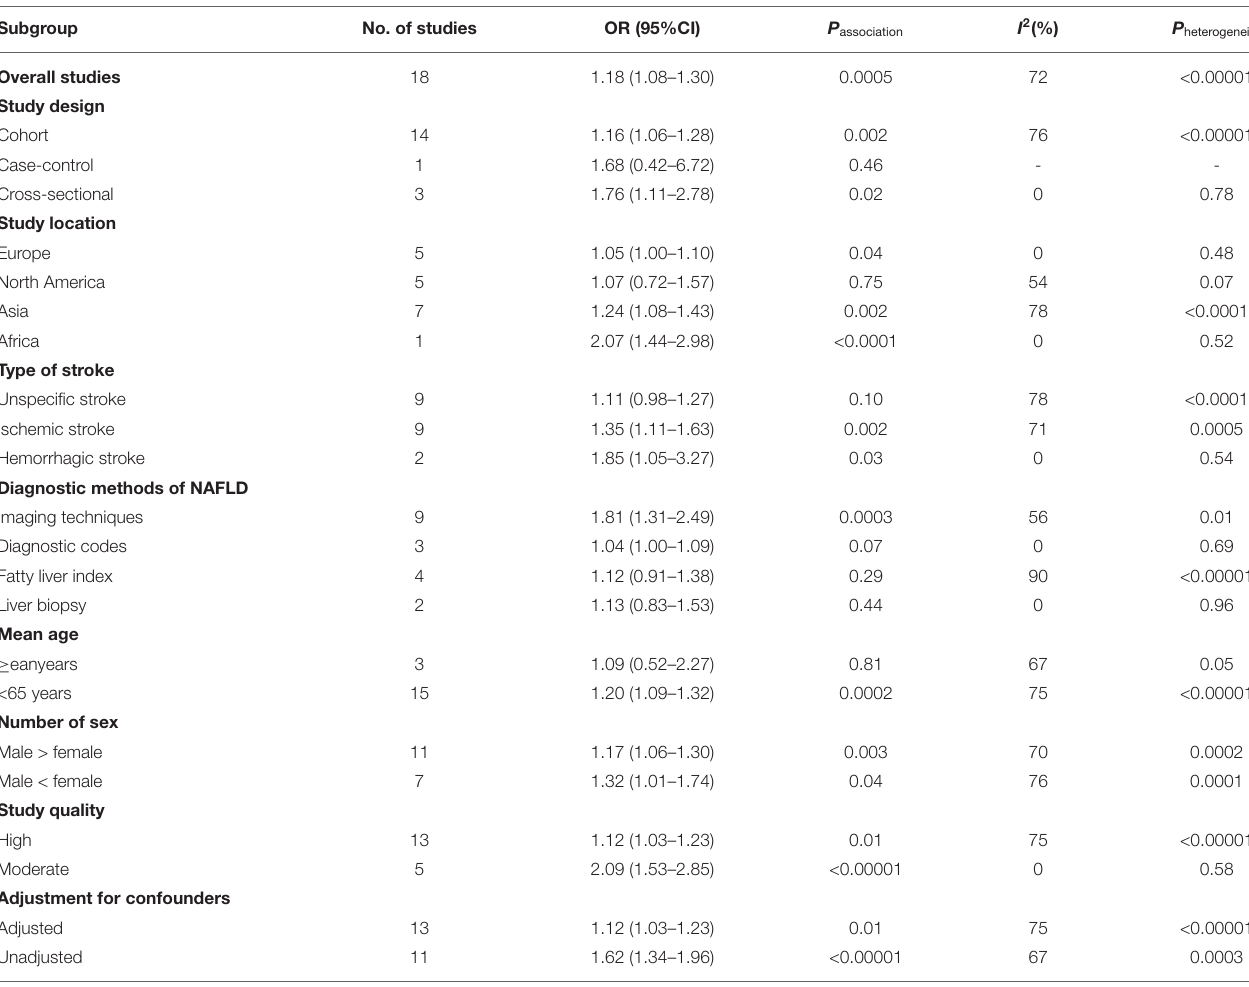
TABLE 2 | Subgroup analyses of association between NAFLD and risk of stroke. Subgroup